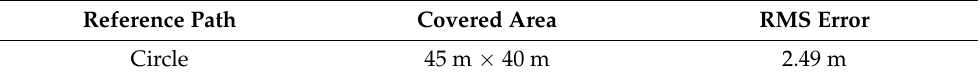
Table 7. The positioning results without any estimation design in the practical experiments.